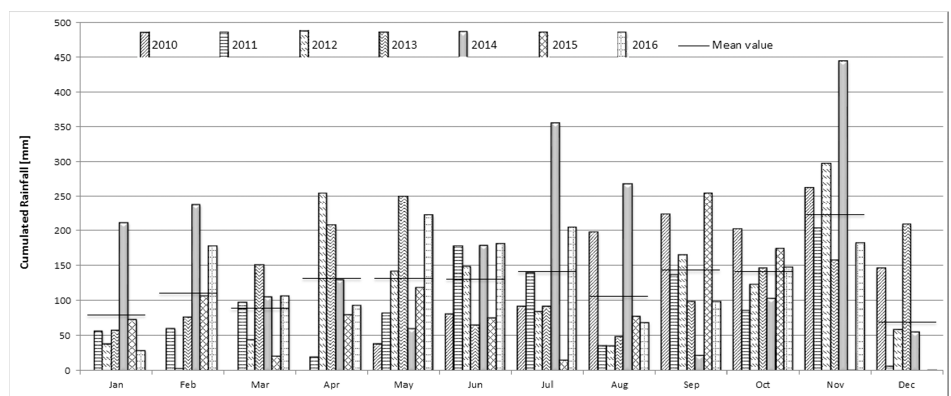
Figure 8. Urbanized (colored zones) and non-urbanized (dotted zones) areas in the model domain. The morainic arc in the right part of Grandate is contoured in black.